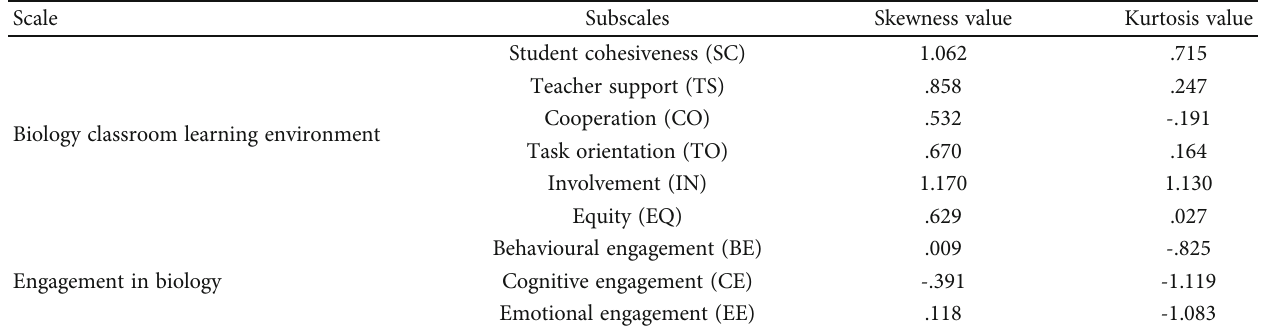
Table 2: Subscale skewness and kurtosis values of the scales employed in the study.